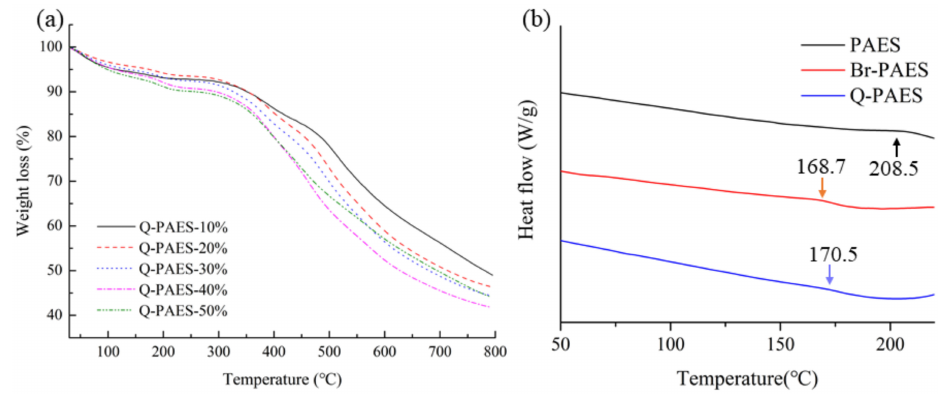
Figure 5. ( a ) The TGA graph and ( b ) di ff erential scanning calorimetry (DSC) data of Q-PAESs.